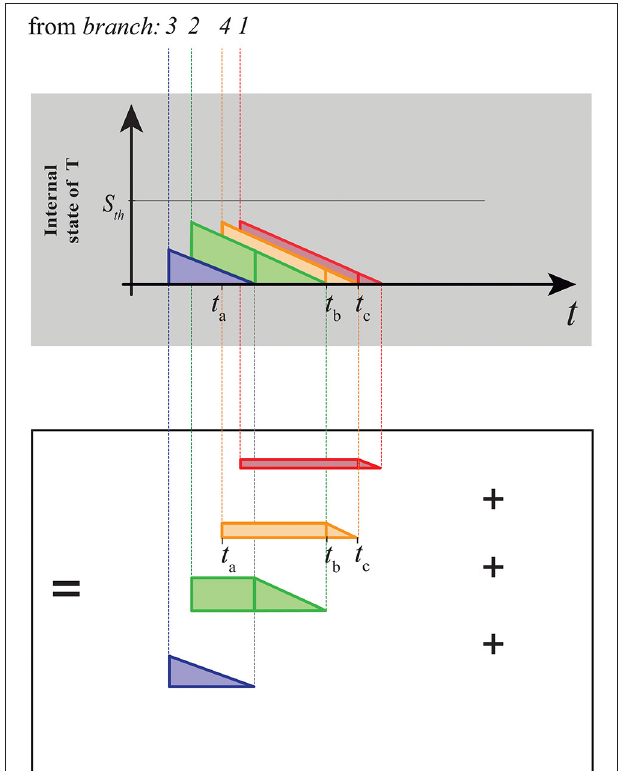
FIGURE 5 | Decomposition of the area subtended by the internal state of the target neuron shown in Figure 4A in terms of trapezoids. Considering the arrival of a generic contribution to the target neuron (e.g., the orange one in A), its advent (at the time t a ) will cause an immediate increase of the value of S T equals to the target weight associated to the afferent contribution. Its contribution on the S T can be considered an additive constant, until the decay due to the previous contribution is exhausted (interval [ t a , t b ], i.e., rectangle part). After this, its contribution will start to decrease linearly (with slope L d ) until the resting potential is reached (interval [ t b , t c ], i.e., triangle